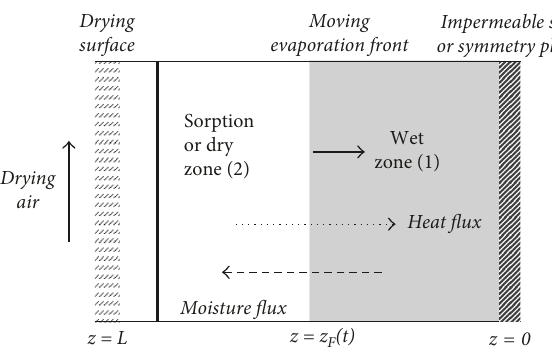
Figure 2: Receding front